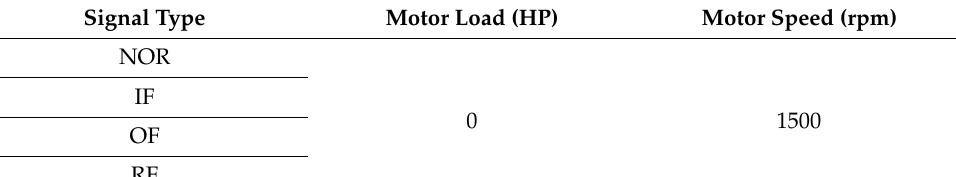
Table 1. Signal Data Type Description.